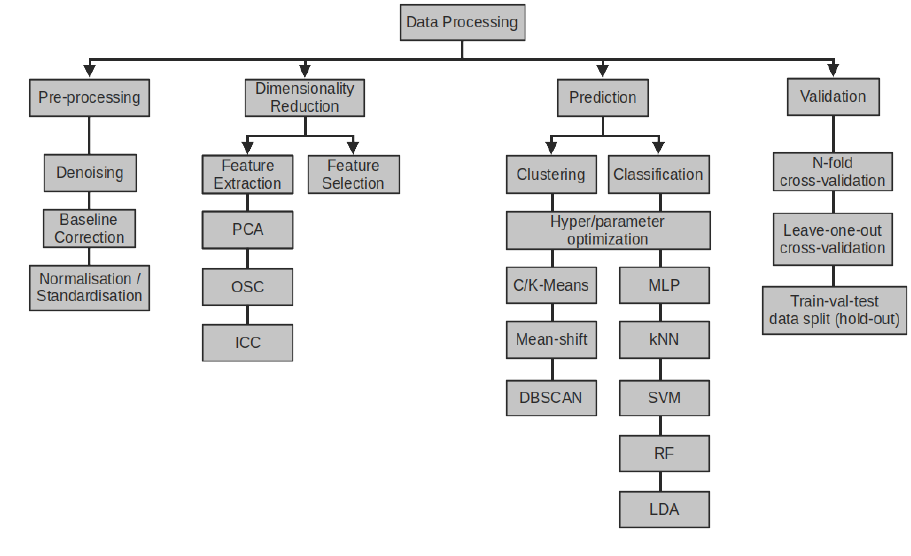
Figure 4. Summary of data processing